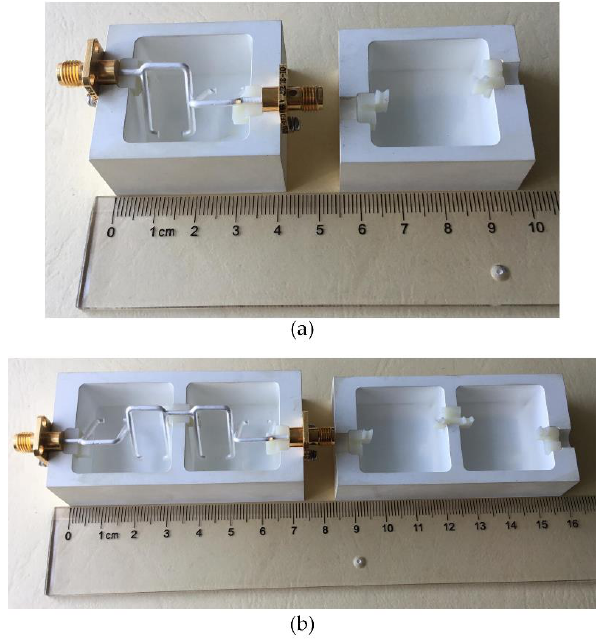
Figure 8. Photograph of the fabricated multi-mode filter ( a ) one-cavity filter; ( b ) two-cavity filter.